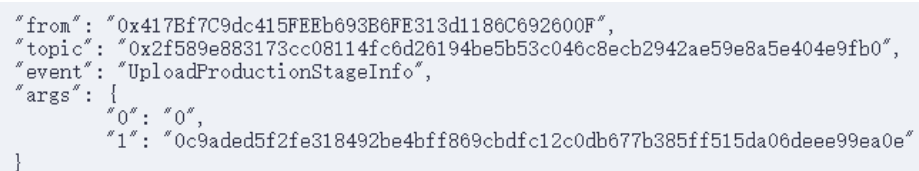
Figure A3. Successful execution of UserForbidden Function.